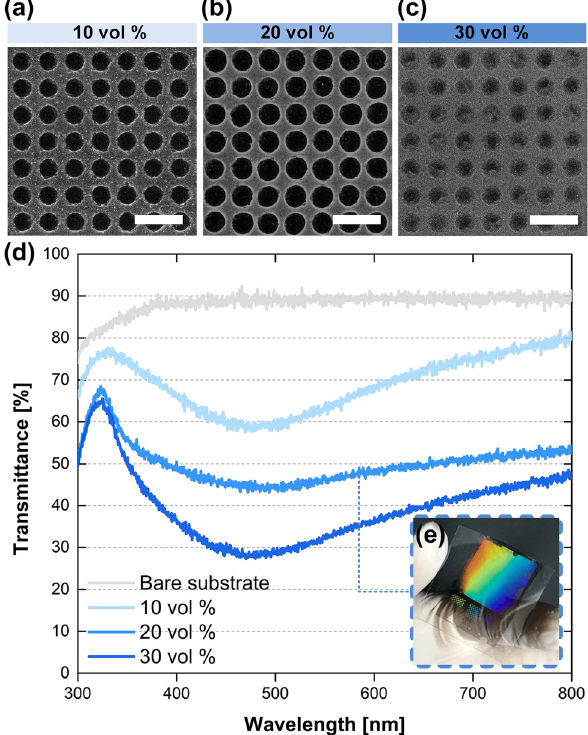
Figure 2: Ag nanohole patterns fabricated by transfer printing of ionicAgink.SEMimagesofAgnanostructuresfabricatedbytransfer printing of ionic Ag ink diluted with (a) 10, (b) 20, (c) 30 vol% in isopropylalcohol(IPA).(d) Opticaltransmittance of the Ag nanohole patterns fabricated by using the ionic Ag inks with various concentrations. (e) Optical photograph of the Ag nanohole structure transfer-printed on the glass substrate by using a 20 vol% ionic Ag ink. All scale bars: 2 µm.